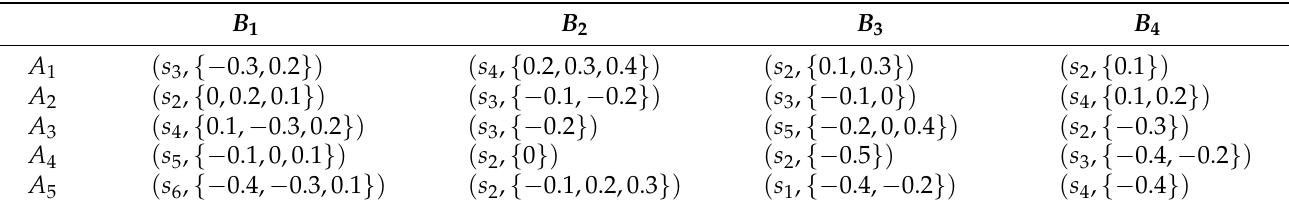
Table 1. The decision matrix M ( 1 ) .